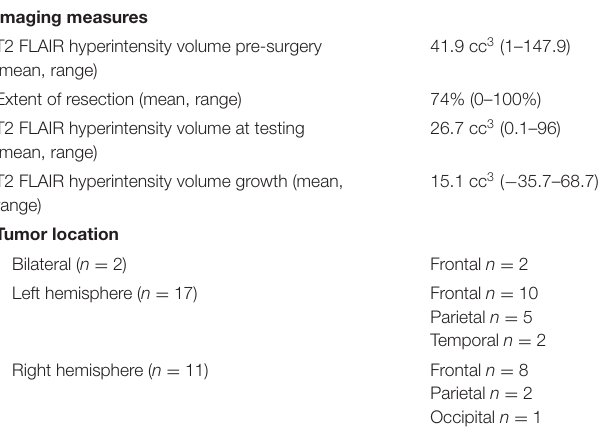
TABLE 2 | Patient demographics and clinical factors. TABLE 3 | Imaging